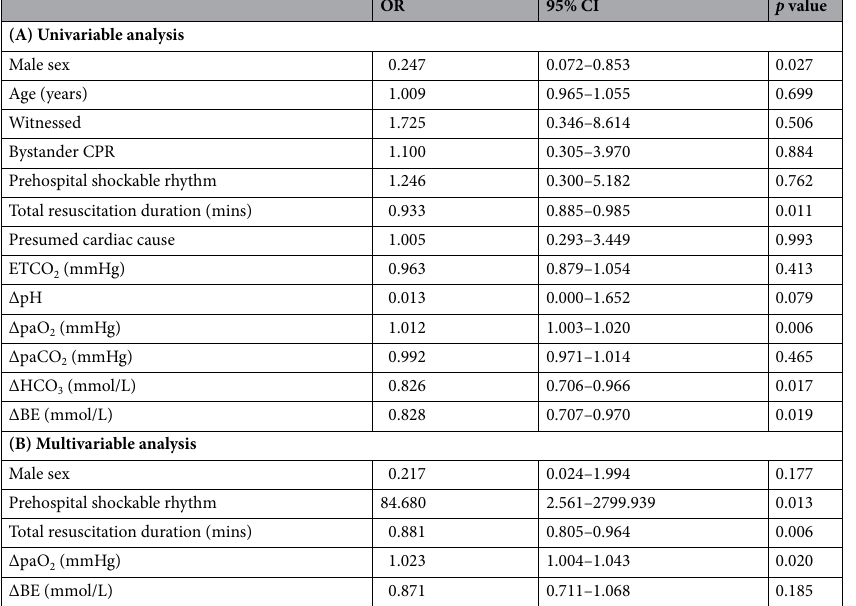
Table 3. Prognostic factors of included patients and the delta values of arterial blood gas parameters. The endpoint for all calculations was sustained return of spontaneous circulation (ROSC). BE base excess, CI confidence interval, CPR cardiopulmonary resuscitation, ETCO 2 end-tidal carbon dioxide, HCO 3 bicarbonate, OR odds ratio, paO 2 partial pressure of arterial oxygen, paCO 2 partial pressure of arterial carbon dioxide. (A) Univariable logistic analysis for the variables with assumed prognostic relevance. (B) Multivariable logistic analysis (stepwise backward elimination using likelihood ratio) for the variables presented in